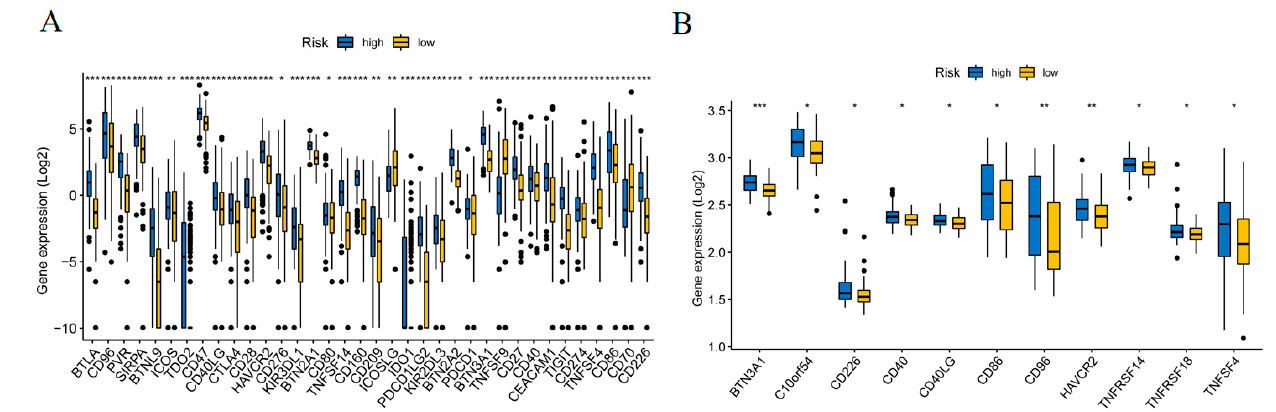
Figure 7. Comparison of the ssGSEA scores of immune cells and immune pathways for two subgroups in both the TCGA-TARGET and GEO cohorts. ( A , B ) Enrichment scores of 16 types of immune cells ( A ) and 13 immune-related pathways ( B ) between low- (green box) and high-risk (red box) group in the TCGA cohort. ( C , D ) Enrichment scores of 16 types of immune cells ( C ) and 13 immune-related pathways ( D ) between low- (green box) and high-risk (red box) group in the GEO